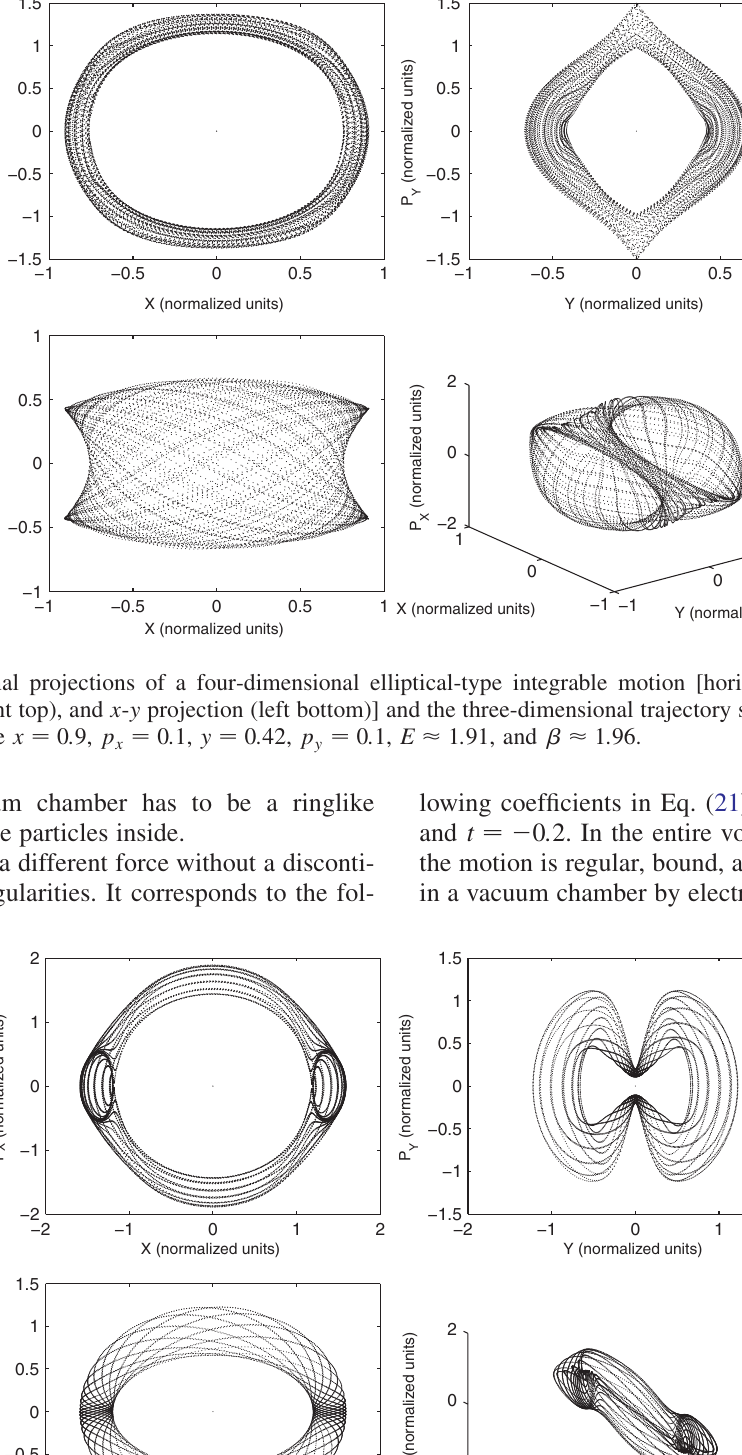
FIG. 3. Same as Fig. 2 except for initial conditions that are taken to be x ¼ 1 : 2 , p (cid:1) (cid:3) 0 : 98 ).